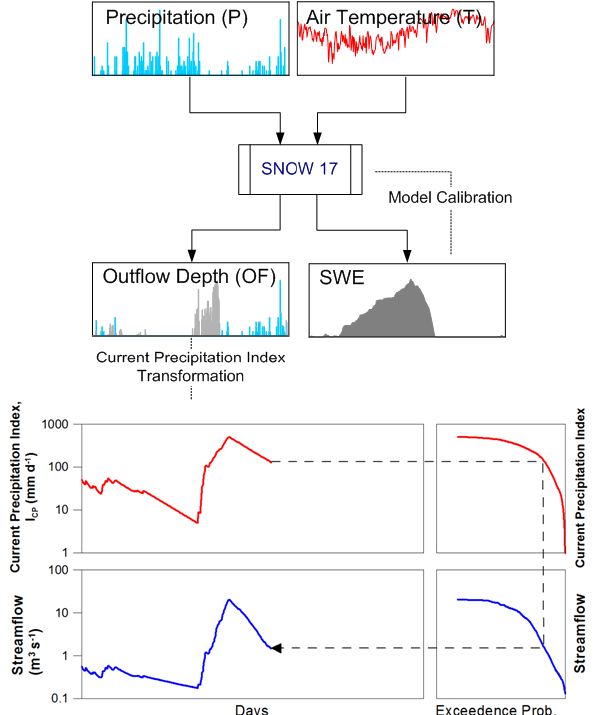
Fig. 2. Details of the proposed modeling approach with the FDC method and the SNOW-17 model.